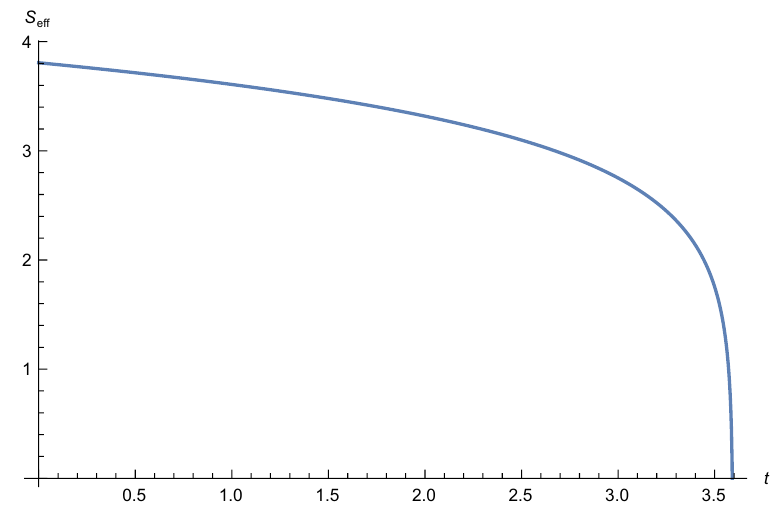
Figure 2 . Plot of the effective entropy S eff . We set ξ = 18 , g s = 1 / 100 in this